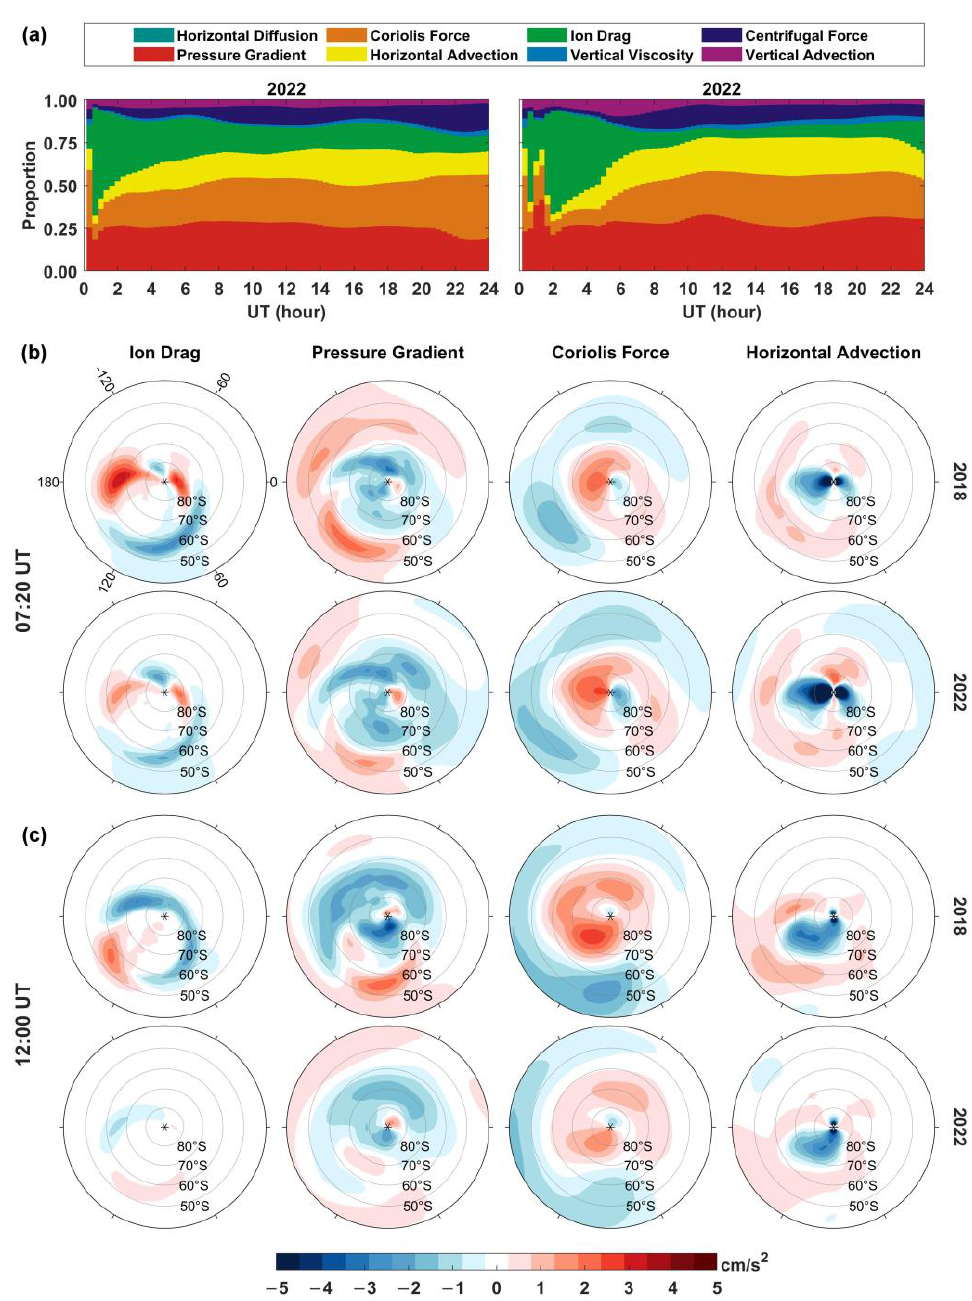
Figure 8. ( a ) The ratios of eight acceleration terms in the meridional wind as shown in Equation (4). ( b ) Mainly meridional acceleration terms: ion drag force (first column), pressure gradient force (second row), Coriolis force (third row), and horizontal advection (fourth row) for the 2018 event (first row) and 2022 event (second row) around 130 km on the first day of the storm (April 20 for the 2018 event and April 10 for the 2022 event) at 07:20 UT. ( c ) Same as ( b ), but corresponding to 12:00 UT. The black asterisks mark the locations of the South Pole.